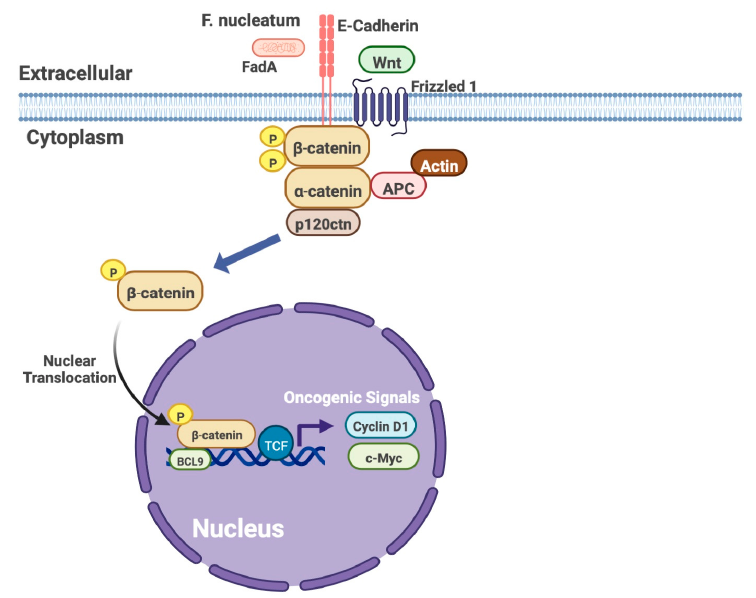
Figure 2. Induction of carcinogenesis by F. nucleatum FadA via modulation of Wnt/ β -catenin signaling pathway.